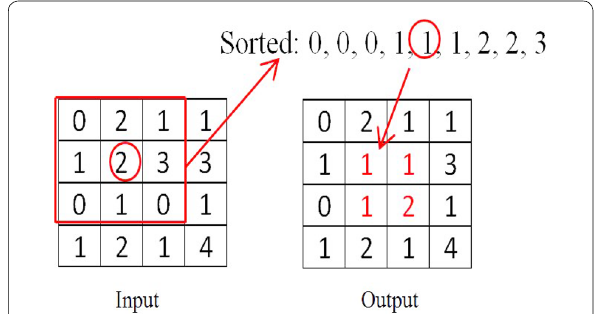
Fig. 3 Example of a median filter using a 3 values inside the window are sorted, and then, find the median value and put the value in the middle of that window, thus keeping this process from left to right and then top to